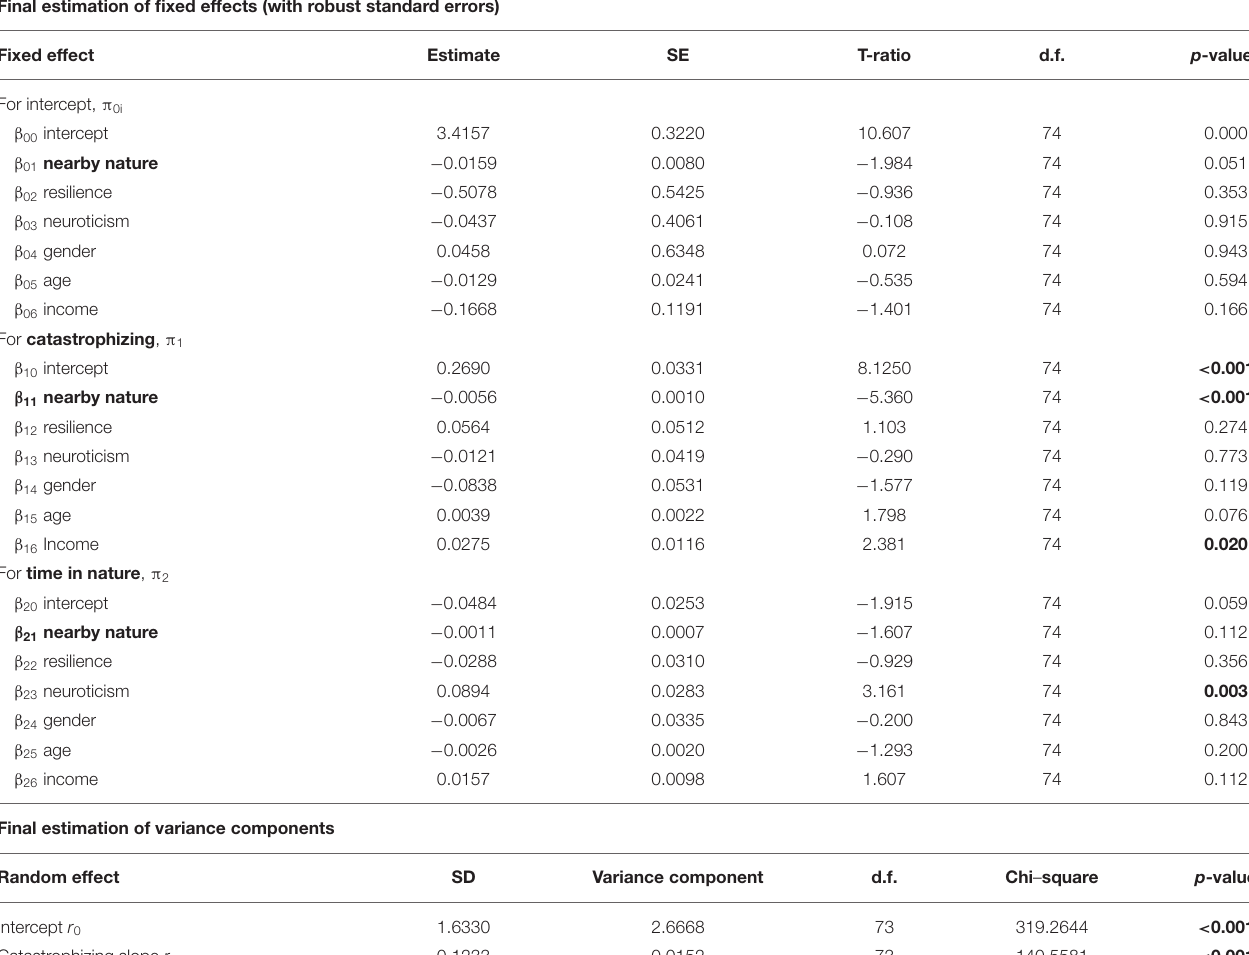
TABLE 2 | RQ1: Multilevel regression predicting daily pain intensity including catastrophizing. Final estimation of fixed effects (with robust standard errors)